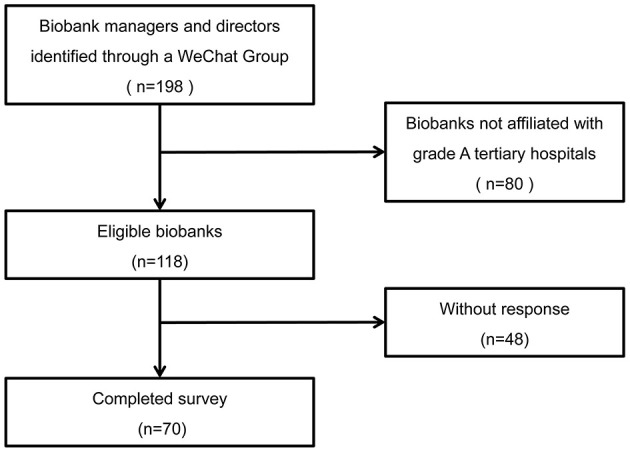
Flow diagram of the study.